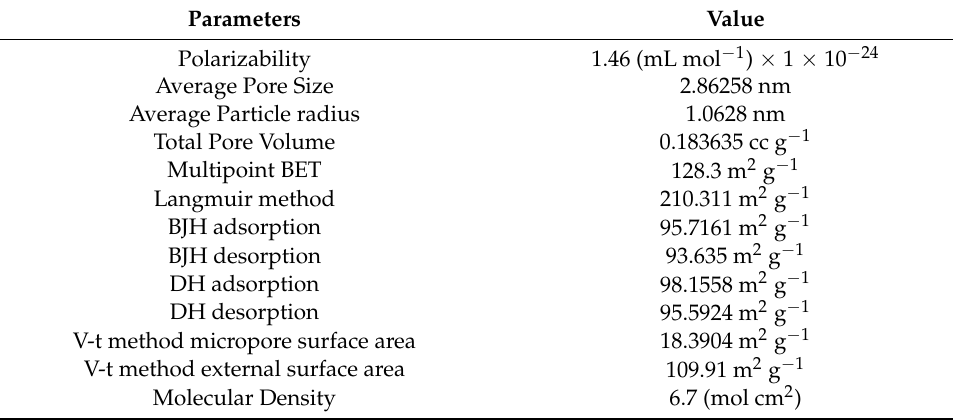
Table 2. Main properties of powdered P. capillacea